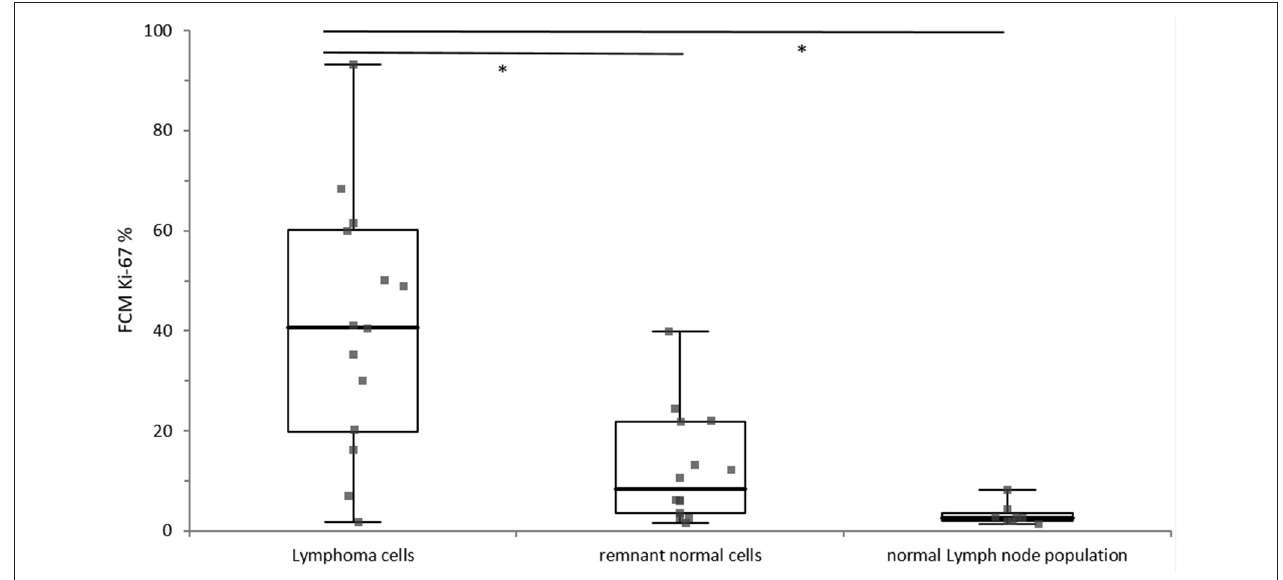
FIGURE 2 | Distribution of Ki-67 expression of the lymphoma cells ( n = 14), the remnant normal cells within in the lymphoma sample ( n = 14) and the normal lymph node population ( n = 8). The different cell populations are grouped along the x-axis and the percentage of Ki-67 positivity is depicted on the y-axis. The boxes represent the 1st and 3rd quartile of of the population, the solid line within the box represents the median, and the whiskers show the minimum and the maximum. Significant difference is marked